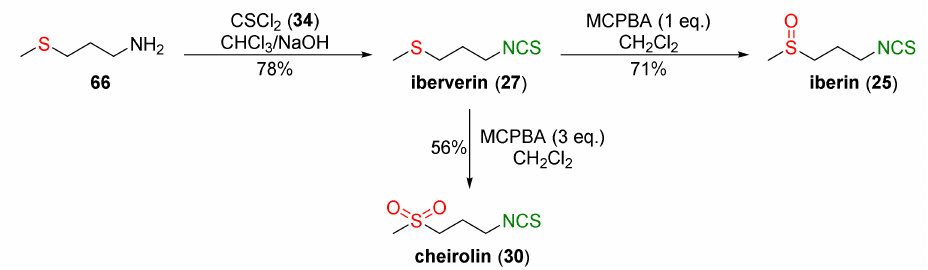
Figure 19. Synthesis of iberverin ( 27 ), iberin ( 25 ), and cheirolin ( 30 ). It was found that iberin ( 25 ), iberverin ( 27 ), and cheirolin ( 30 ) significantly induced Nrf2 nuclear translocation in NIH3T3 fibroblasts. The increase of nuclear Nrf2 levels was accompanied by an increase of heme oxygenase (HO-1) and γ -glutamylcysteine synthetase ( γ GCS) mRNA and other protein levels. Iberverin ( 27 ), iberin ( 25 ), and cheirolin ( 30 ) exhibited a similar potency to SFN ( 24 ) in terms of their Nrf2-dependent gene expression. Induction of Nrf2 by iberverin, iberin, and cheirolin may have occurred via the extracellular signal-related kinase (ERK)-dependent signal-transduction